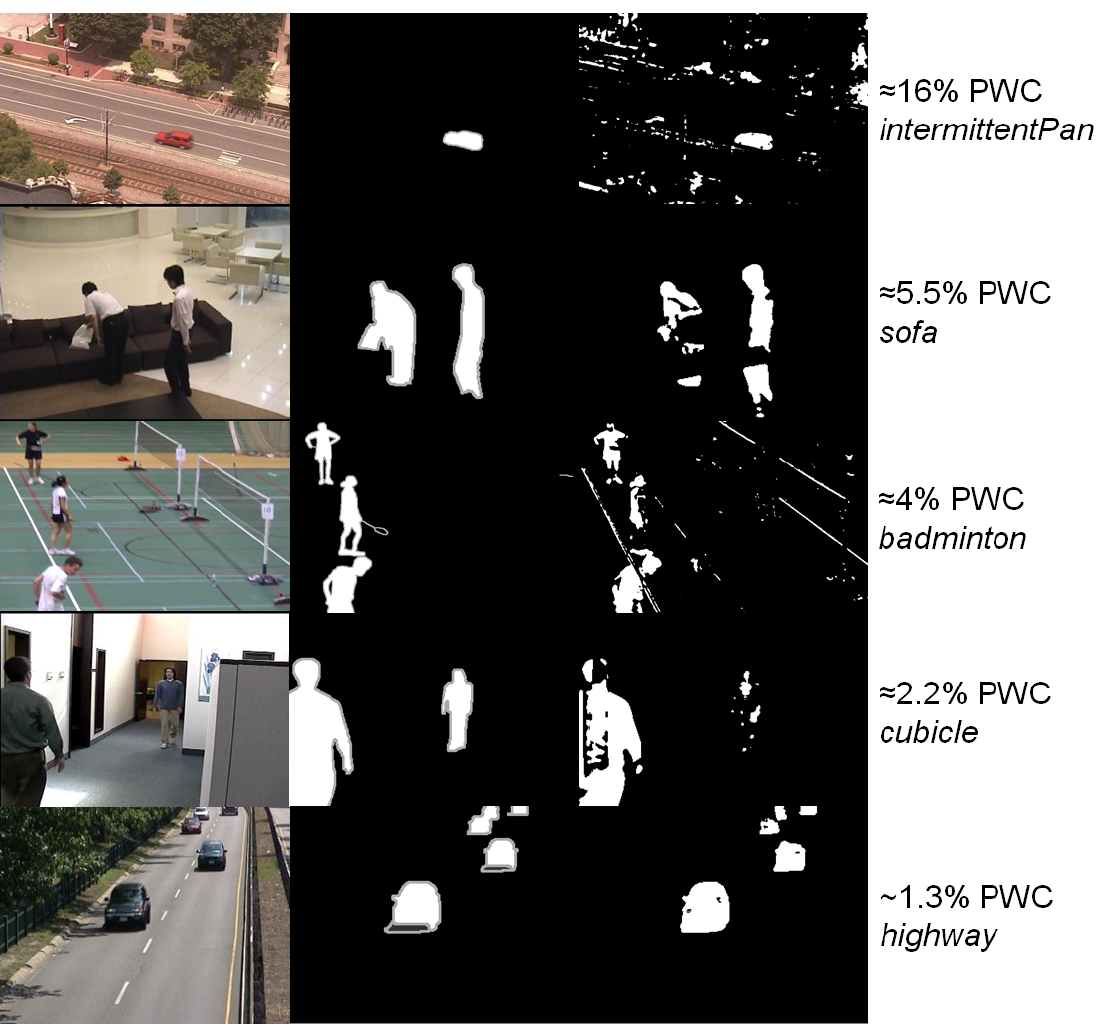
Figure 1. Examples of background estimation with different levels of PWC. In each row, the leftmost image is the raw image, the middle image is the ground truth, and the right image is the output of the Zivkovic GMM algorithm [12], with the approximate PWC and name of the sequence from the CDW2014 [15] dataset on the